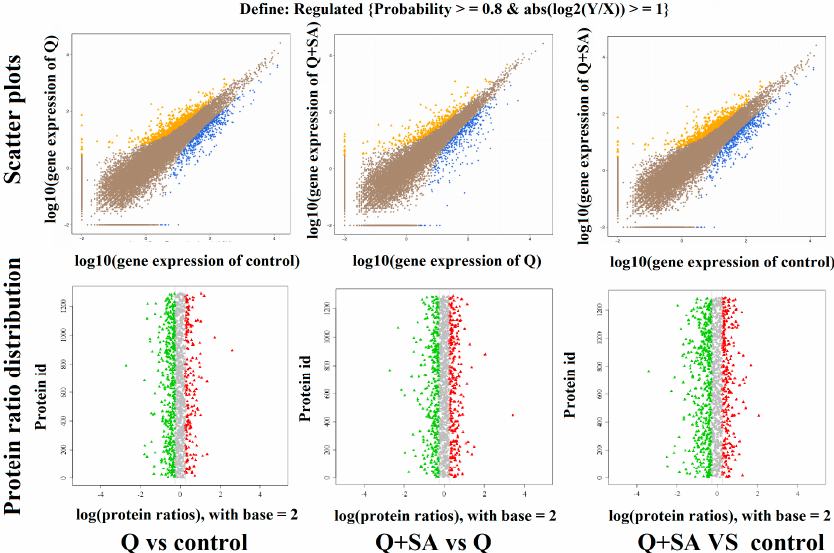
Figure 4. Scatter plots of gene expression level and the protein abundance distribution of expressed proteins. In the scatter plot, blue dots represent down-regulated genes, orange dots represent up-regulated genes, and brown dots represent non-regulated genes; whereas, in the protein-abundance distribution figures, green and red dots represent significantly down-regulated and up-regulated proteins, respectively. The grey dots represent insignificant changed proteins.